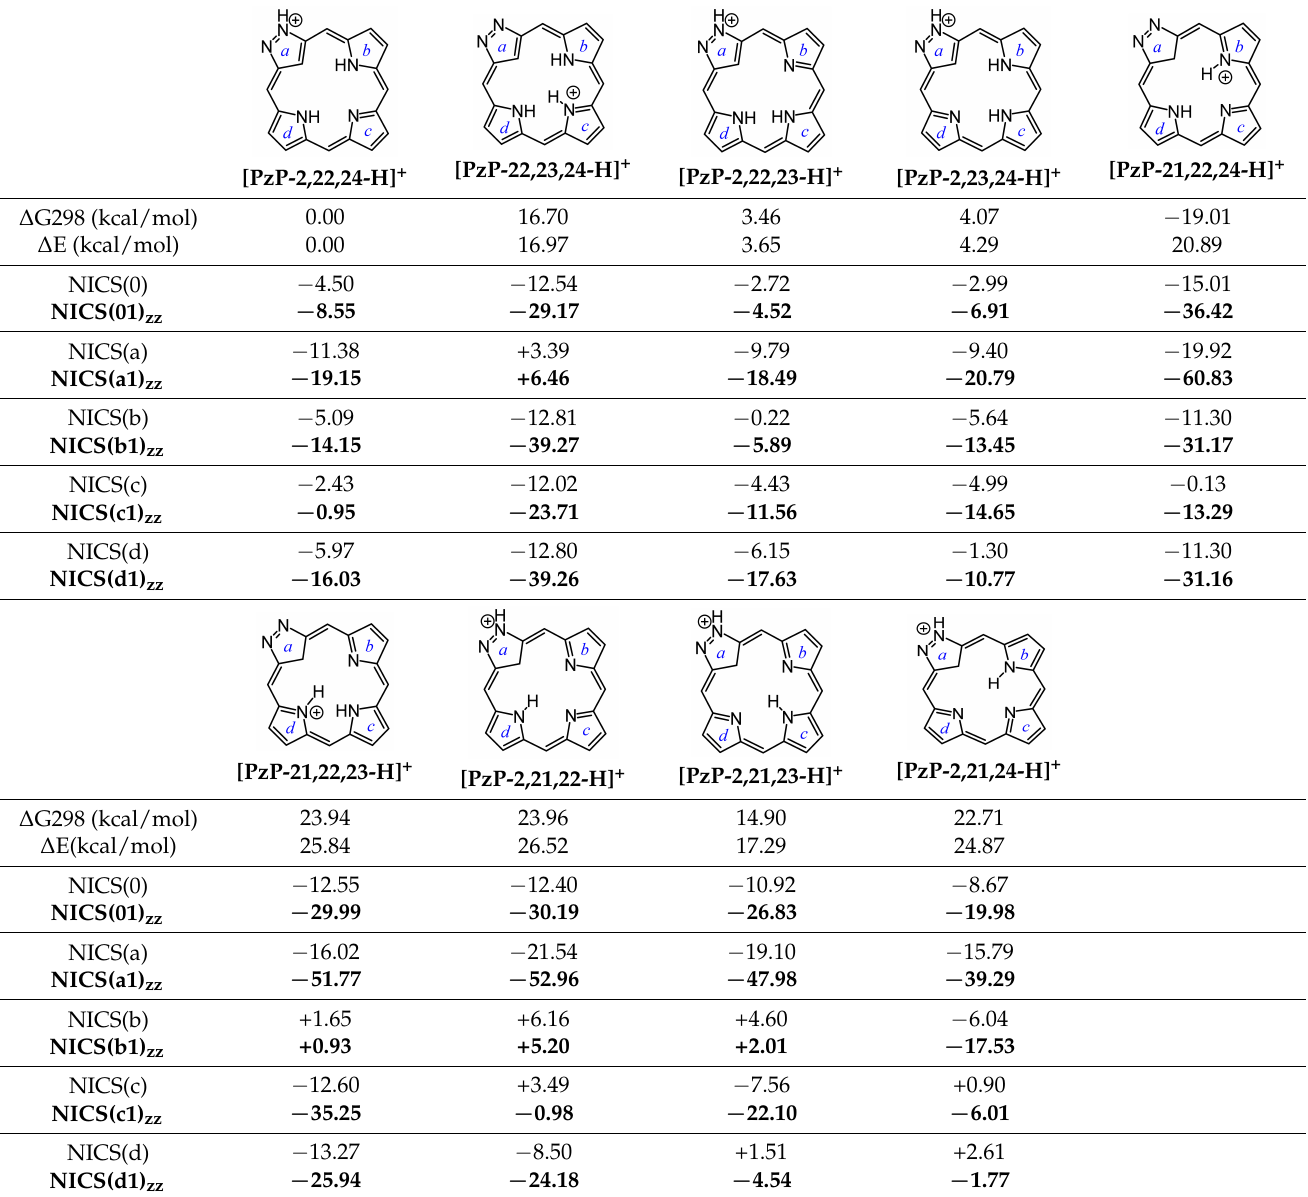
Table 4. Calculated Relative Energies (kcal/mol) and NICS Values (ppm) for Monoprotonated Pyrazoloporphyrin